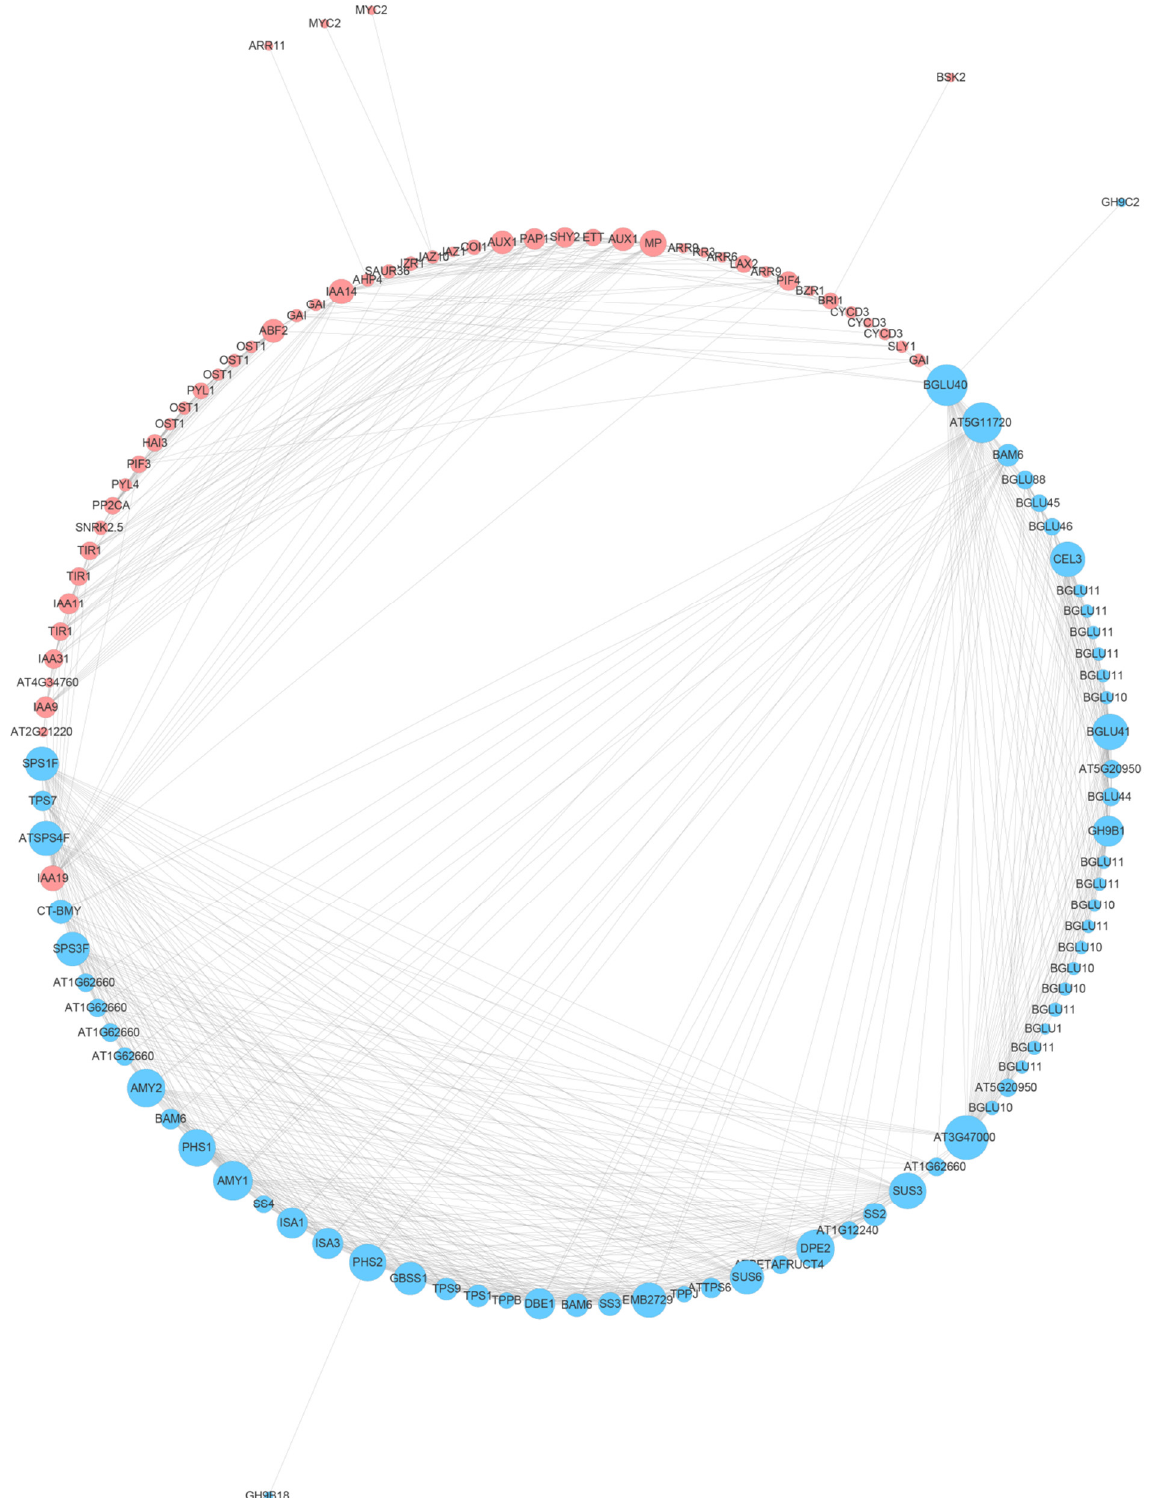
Figure 8. Protein–protein interaction (PPI) network among the starch and sucrose metabolism pathway and the plant hormone signal transduction pathway. The blue and red nodes represent the sucrose metabolism pathway and the plant hormone signal transduction pathway, respectively. The diameters of the nodes represent the interaction frequency.